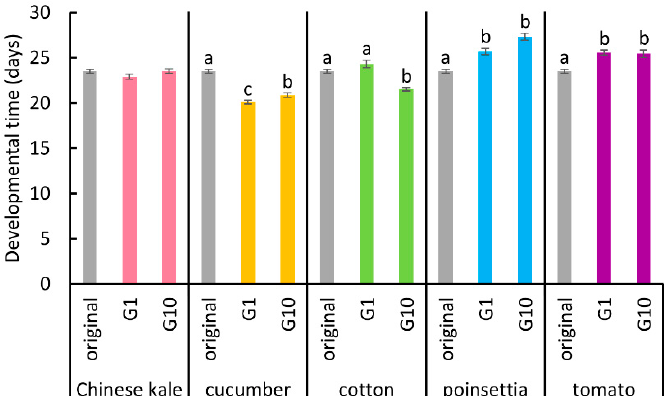
Figure 2. The developmental time of “egg and nymphal stages” of B. tabaci reared on each host plant in the first and tenth generations, and the original colony. Vertical bars indicate standard errors. Different letters indicate significant differences (Dunn’s test, p < 0.05).